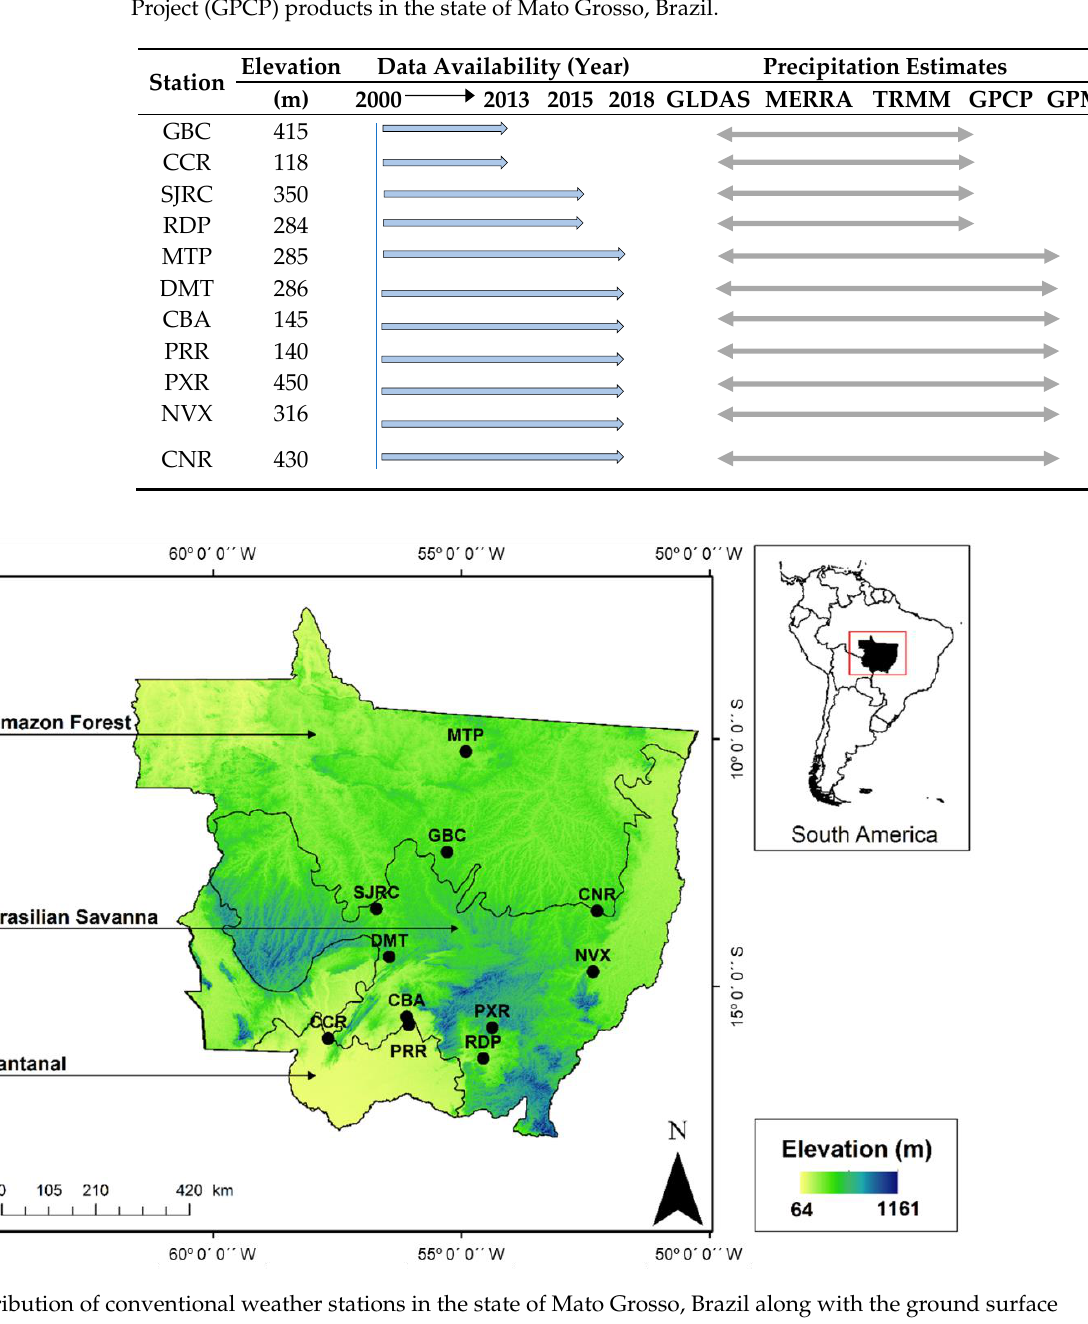
Table 1. Available data from conventional weather stations, including Cáceres (CCR), Canarana (CNR), Cuiabá (CBA), Diamantino (DMT), Gleba Celeste (GBC), Matupá (MTP), Nova Xavantina (NVX), Padre Ricardo Remetter (PRR), Poxoréu (PXR), Rondonópolis (RDP), and São José do Rio Claro (SJRC), used to validate precipitation estimates for Global Land Data Assimilation (GLDAS), Modern-Era Retrospective Analysis for Research and Applications (MERRA), Tropical Rainfall Measurement Mission (TRMM), Global Precipitation Measurement (GPM), and the Global Precipitation Climatology Project (GPCP) products in the state of Mato Grosso, Brazil.